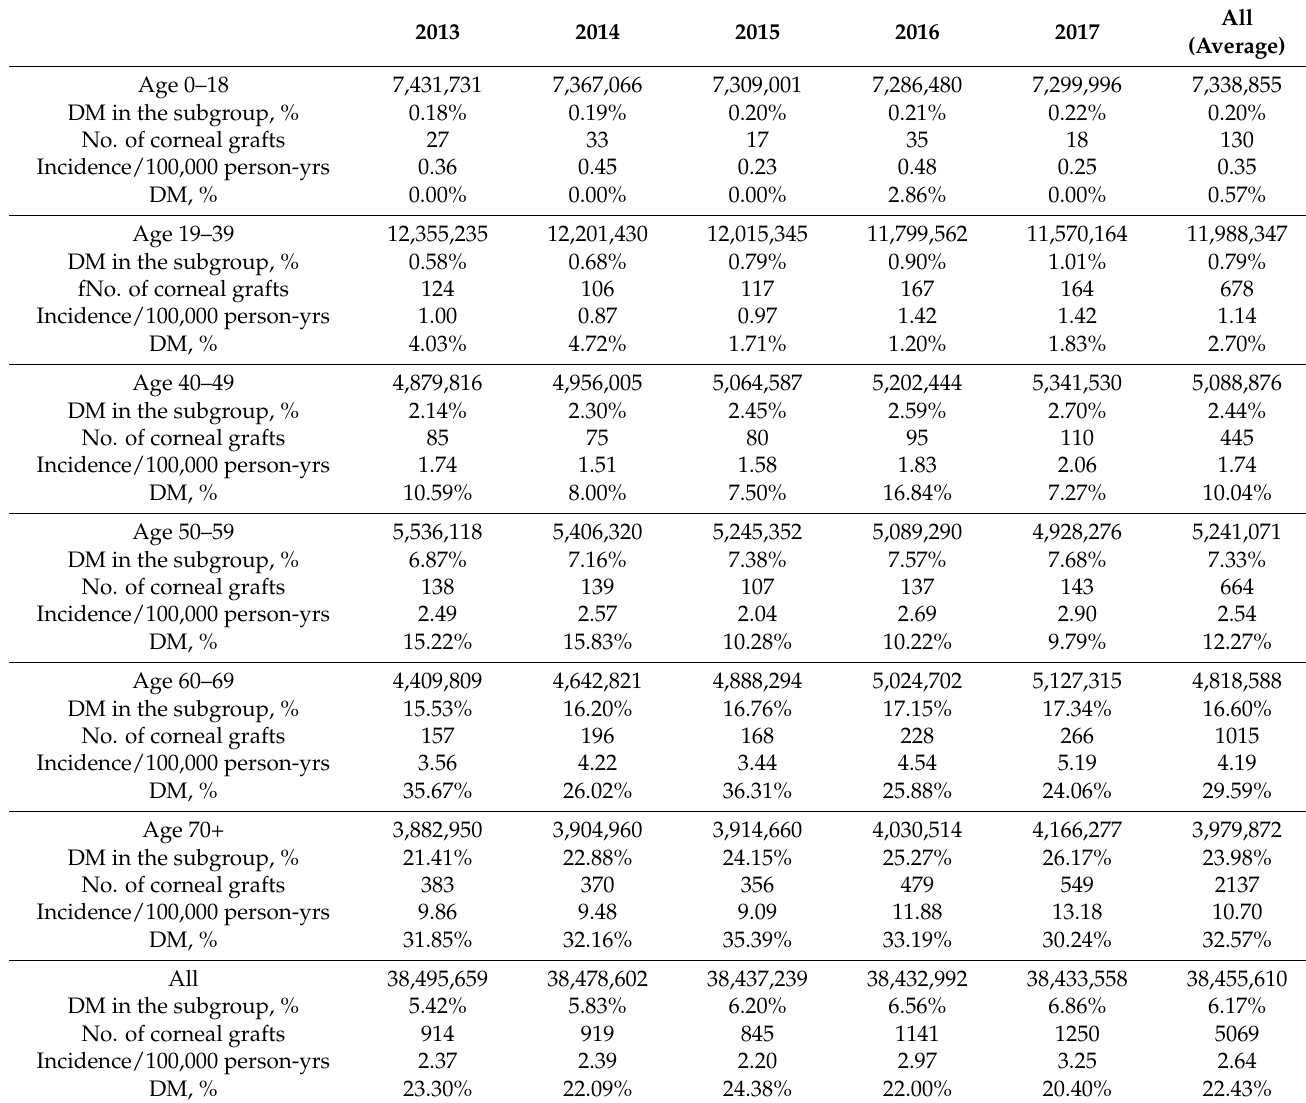
Table 1. Incidence of corneal grafts in Poland during 2013–2017.